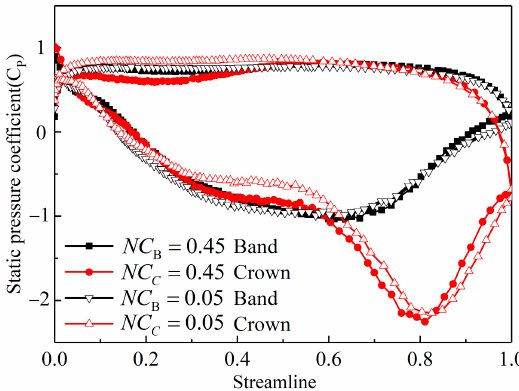
Figure 9. Static pressure coefficient at both crown and band for different NC C (the first interaction point between the straight line and the parabolic line at the crown) .